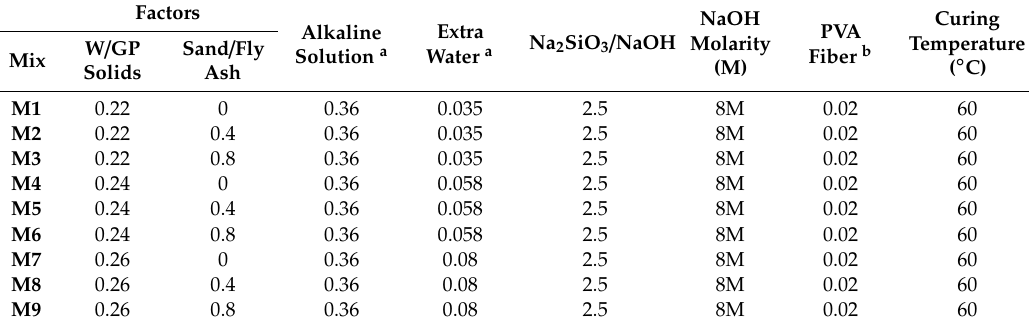
Table 6. Mix designs of engineered geopolymer composite